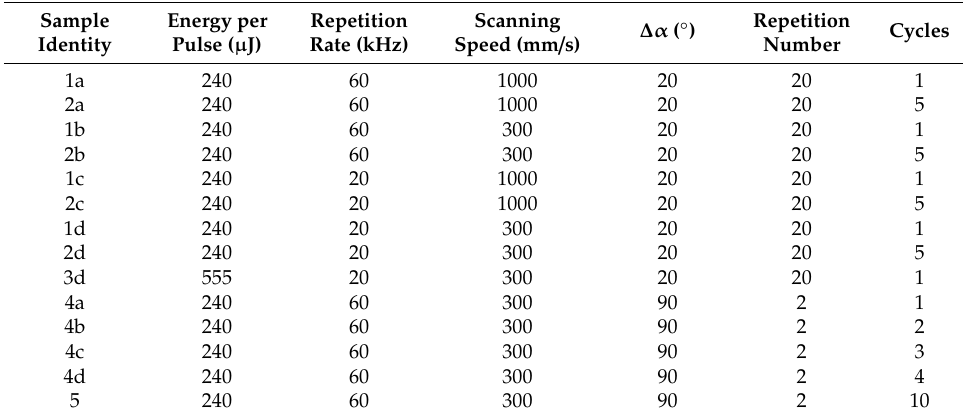
Figure 3. Laser treatment of ceramic surfaces: scheme of the process with different angles ( ∆ α = 20 ◦ or 90 ◦ ). Table 1. Laser process parameters used to treat the ceramic